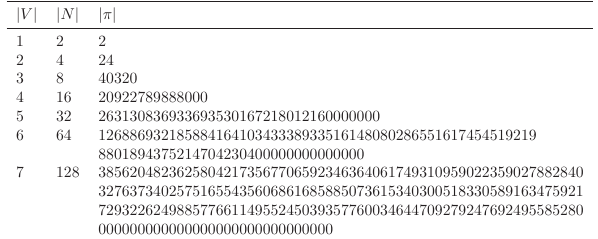
Figure 7. elimination orders, respectively.